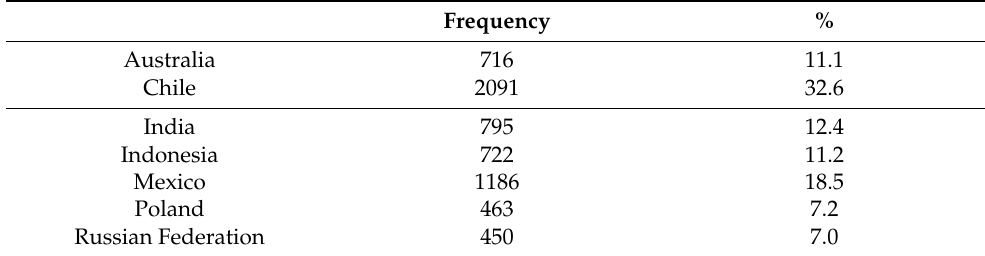
Table 1. Distribution of participants by